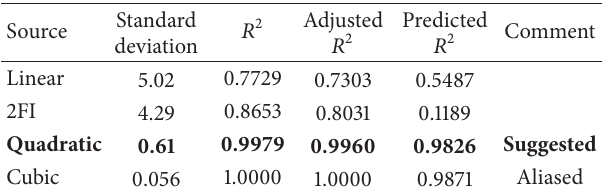
Table 2: Regression statistics for removal efficiency (model for response 𝑌 1 ).